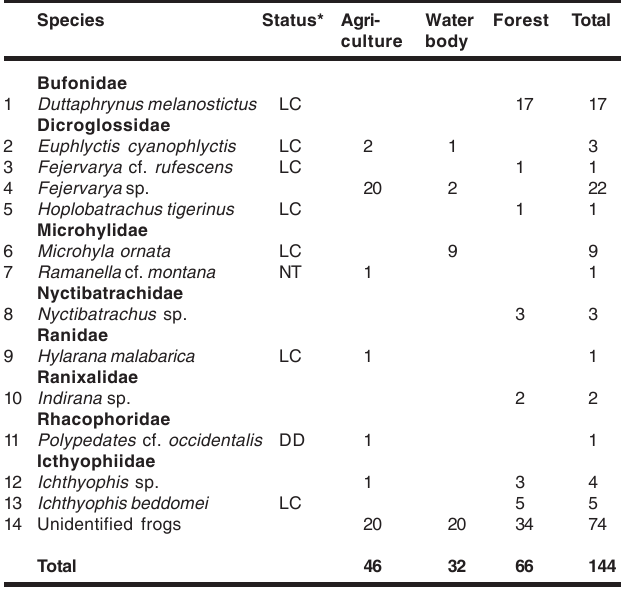
Table 1. Amphibian road kills and encounter rate (individual/1.2km) across